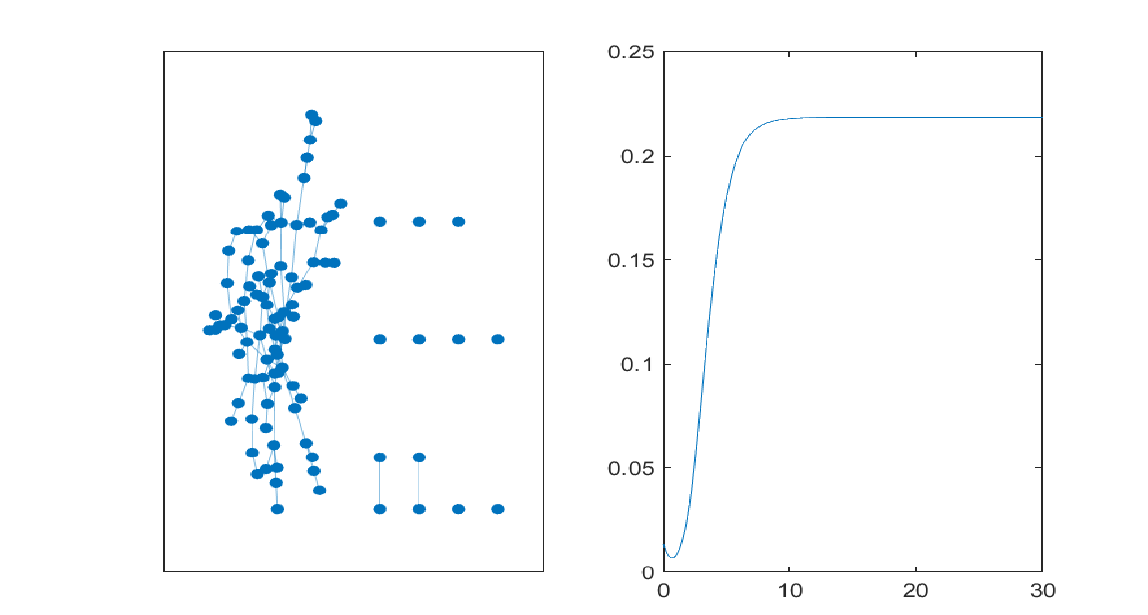
Figure 7. Medium level of connectivity:Erdös–Rényi graph with 100 nodes and a connection probability of p ∼ 0.02 ( left ). Time evolution of the mean value of non-performing loans on the graph ( right ).